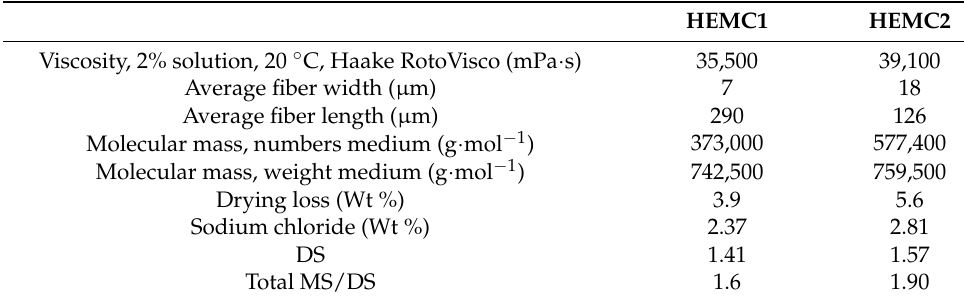
Table 3. Physico-chemical properties of HEMC1 and